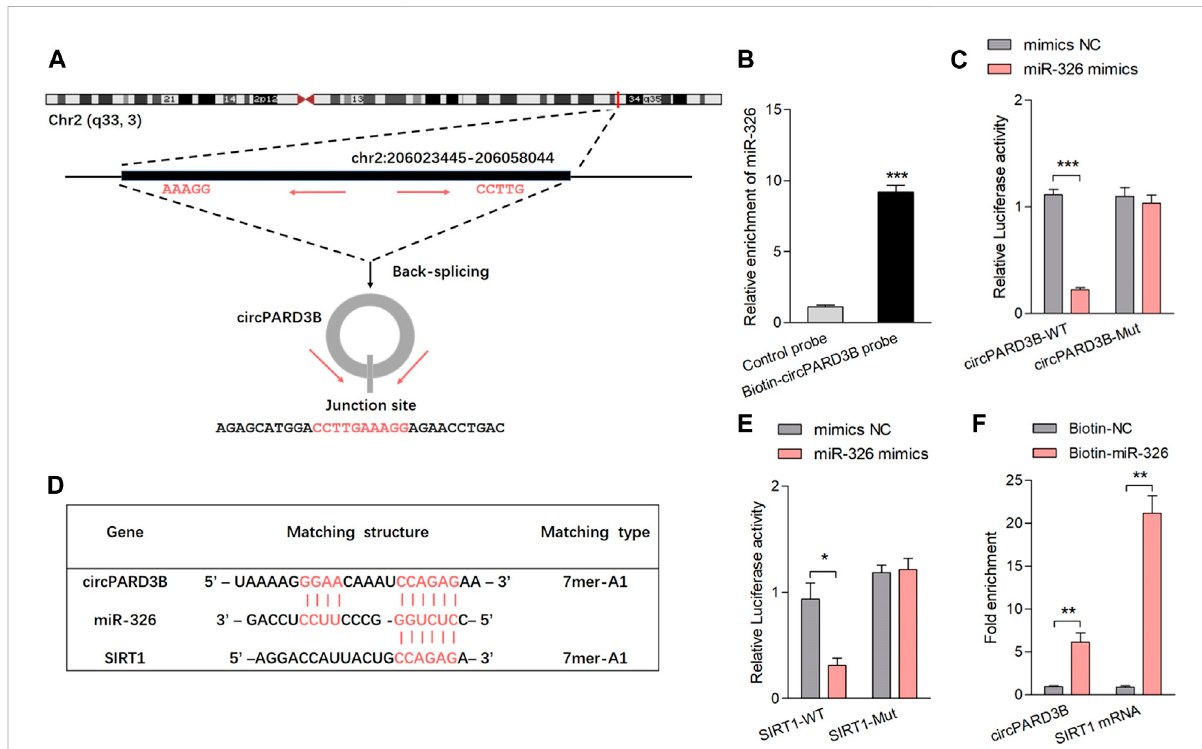
FIGURE 2 CircPARD3B interacted with miR-326, further targeting SIRT1. (A) Characteristics of hsa_circ_0008172 (circPARD3B). (B) MiR-326 was pulled down and enriched with biotinylated circPARD3B probe (n = 3). (C) When co-transfected with wild circPARD3B as well as miR-326 mimics, the relativelucactivityofcircPARD3Bwasevidentlysuppressed (n=3). (D) SchematicgraphillustratingbindingsitesbetweencircPARD3BandmiR-326, miR-326 and SIRT1 mRNA. (E) LRA revealed that the luc activitiy of SIRT1 wild type reporter was decreased with statistical signi fi cance when transfectedwith miR-326mimicsincontrastwith control reporter ormutatedluciferase reporter(n =3). (F) Anenrichment ofcircPARD3B as wellas SIRT1 mRNA in the pulled down sediments of 3 ′ end biotin-labeled miR-326 with statistical signi fi cance (n = 3). Results are described with mean ± S.E.M. CTL = control group. Scrl-KD = scramble siRNA knockdown. NC = negative control. * p < 0.05, ** p < 0.01, *** p <